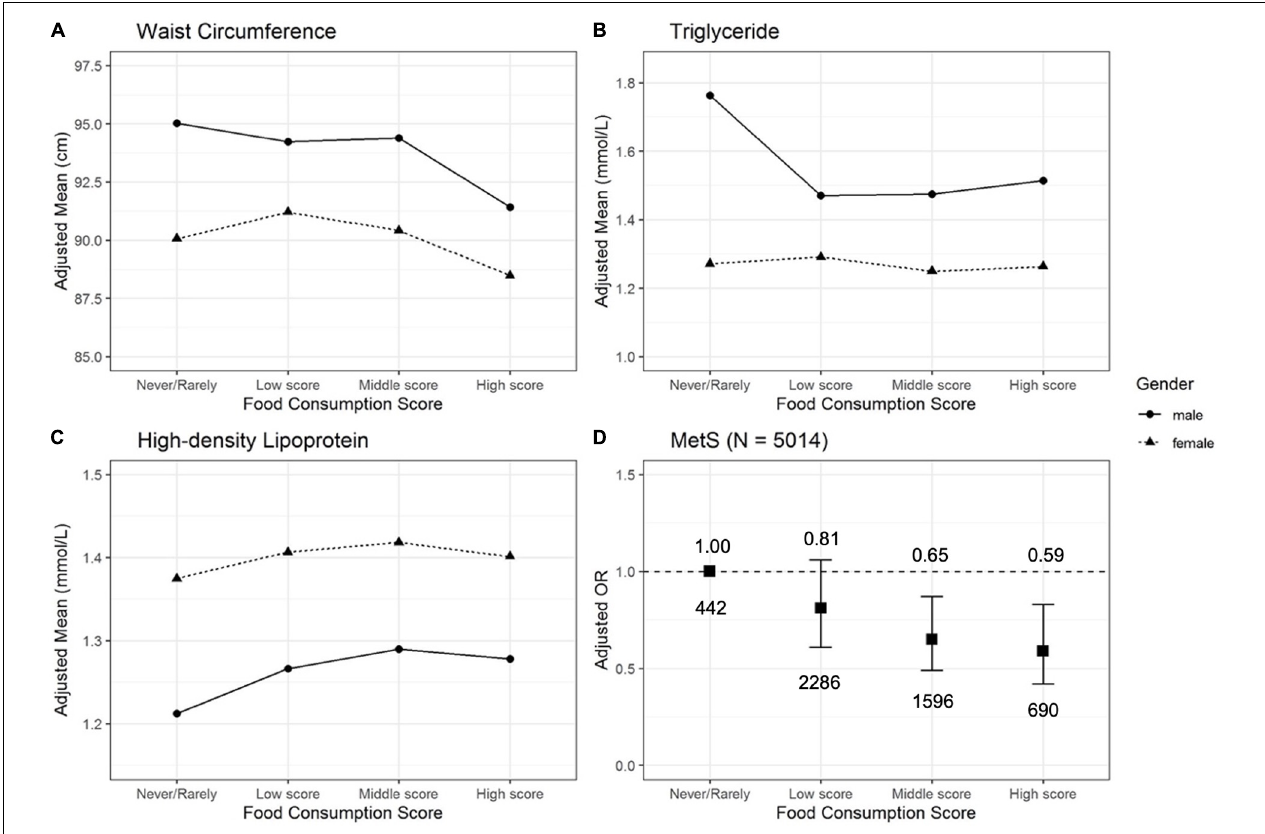
FIGURE 3 | Adjusted mean waist circumference (A) , triglyceride (B) , high-density lipoprotein (C) , and adjusted OR (D) of MetS according to the food consumption score. Mean values for waist circumference, triglyceride, high-density lipoprotein, and OR of MetS were adjusted for age, marital status, educational level, annual household income, smoking status, alcohol intake, physical activity, and consumption of red meat, dairy products, eggs, fresh vegetables, and